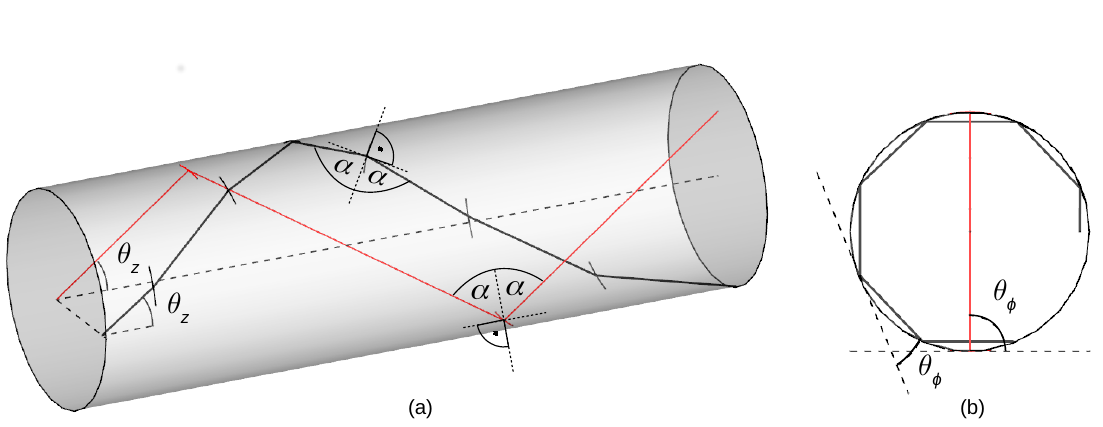
Figure 1. Meridional and skew modes of the same θ z differ by their optical path ( a ) and their skewness θ φ ( b